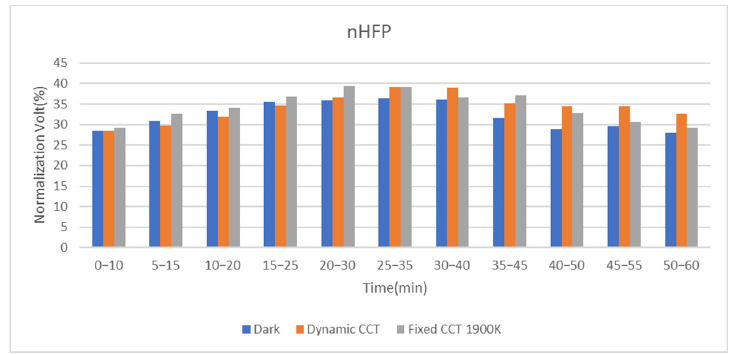
Figure 17. nHFP analysis.